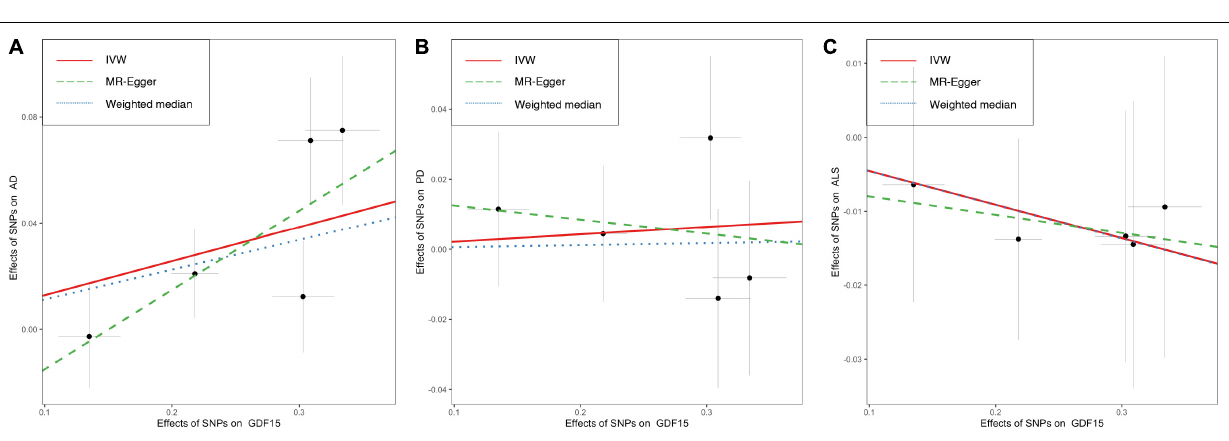
FIGURE 3 | Scatter plots showing the effects of GDF-15 on three neurodegenerative diseases. No evident outlier SNPs were present in the Mendelian randomization analyses of GDF-15 on the risk of Alzheimer’s disease (A) , Parkinson’s disease (B) , and amyotrophic lateral sclerosis (C) . As delineated by fitted lines, overall causal estimates were given by the IVW method (red solid line), weighted median (blue dotted line), and MR–Egger slope (green dashed lines). Individual SNP (black point) with its effect on the risk of neurodegenerative diseases (vertical line) against its effect on circulating levels of GDF-15 (horizontal line) was depicted in the background. AD, Alzheimer’s disease; ALS, amyotrophic lateral sclerosis; CI, confidence interval; GDF-15, growth differentiation factor 15; IVW, inverse-variance weighted model; PD, Parkinson’s disease; SNP, single-nucleotide